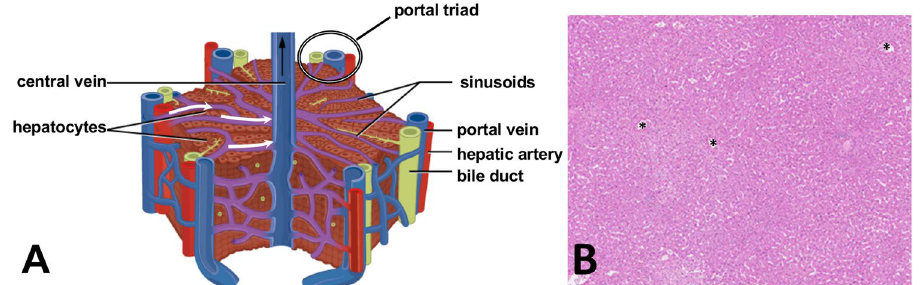
Figure 1. A Schematic of a typical liver lobule. A poroviscoelastic (PVE) model will investigate flow and mechanics at short time scales at this spatial scale. Adapted under CC BY 4.0 from OpenStax. Access for free at https ://opens tax.org/books /anato my-and-physi ology /pages /1-intro ducti on. B Typical human liver histology (hematoxylin and eosin staining), with several central veins marked with *; the parenchyma is a mixture of sinusoids (white spaces) and hepatic cords (pink regions). An agent-based model will investigate tumor- parenchyma interactions over longer times in at this larger spatial scale. Adapted under CC BY-SA 3.0 from the Human Protein Atlas available from http://www.prote inatl as.org 3